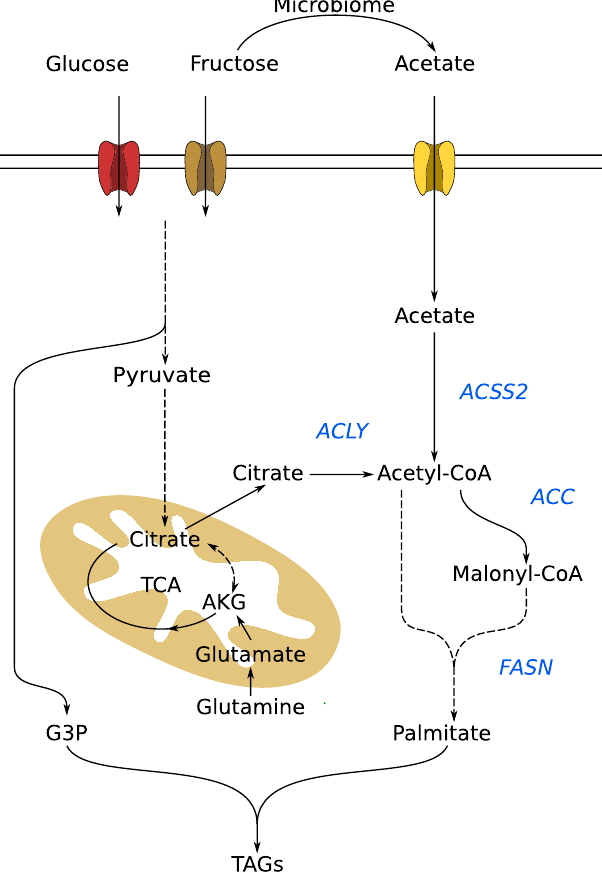
Figure 3. De novo lipogenesis driven by fructose and glucose carbon. Both fructose and glucose can provide carbon for DNL. On the one hand, they can end up in citrate, which is then cleaved by ACLY to provide acetyl-CoA for fatty acid synthesis. On the other hand, they can provide G3P for triacylgyceride synthesis. Besides citrate, cytosolic acetyl-CoA can also be derived from acetate. It was shown that the microbiome of mice converts fructose to acetate. This microbiota-derived acetate is then taken up and utilized for DNL in mice [81]. ACC: acetyl-CoA carboxylase; ACSS2: acyl-coenzyme A synthetase short-chain family member 2; ACLY: ATP citrate lyase; AKG: α -ketoglutarate; FASN: fatty acid synthase; G3P: glycerol 3-phosphate; TCA: tricarboxylic acid cycle; TAG: